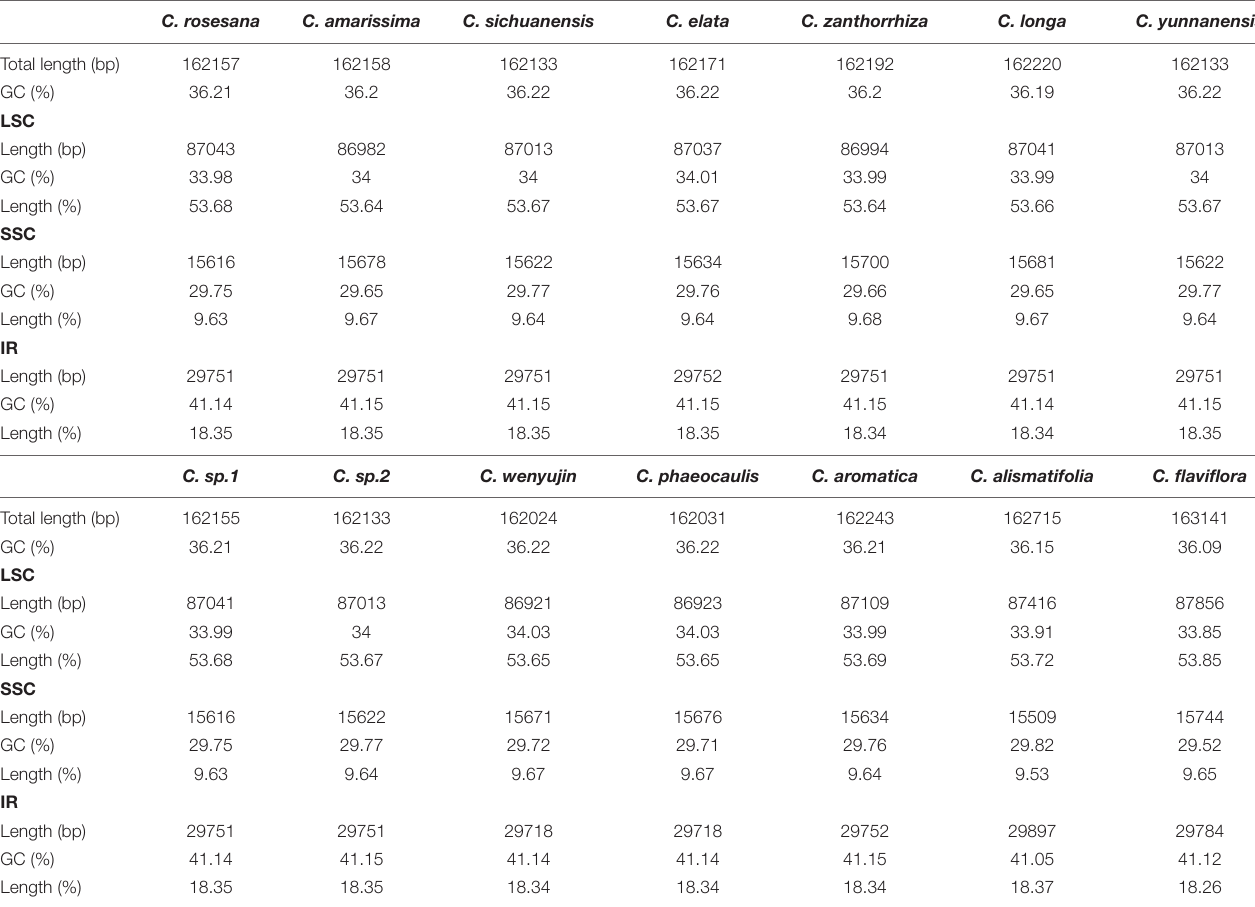
TABLE 1 | Complete chloroplast genomes for 14 Curcuma